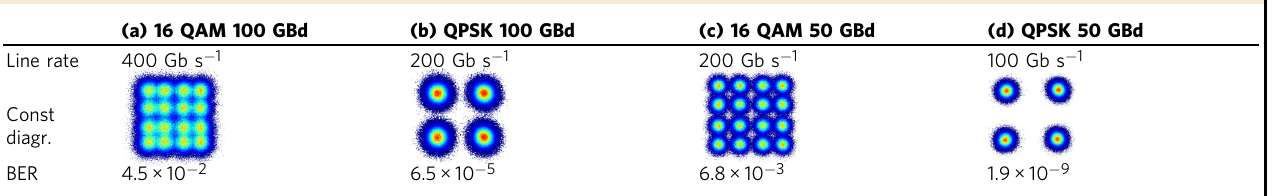
Table 1 Device operation without electronic equalization